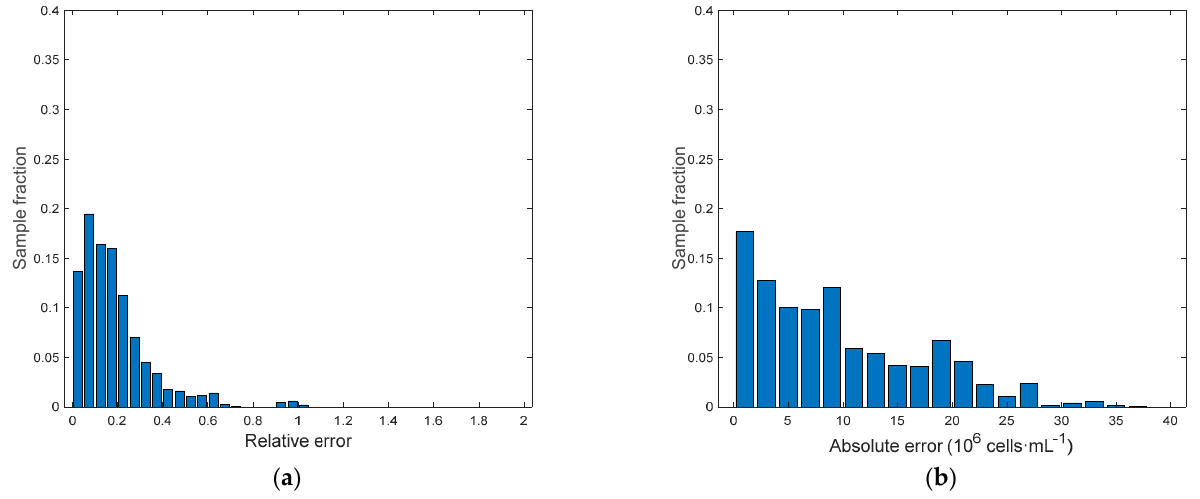
Figure 9. Model C[ 𝐗 𝐂𝐈 |𝐗 𝐅𝐈 ‖ ln(C x )]. ( a ) Relative error distributions. ( b ) Absolute error distributions. In view of the results above, where only wells at D0 were used for calibration and validation, an additional model was built where the number of variables was increased by using the features extracted from diluted wells (Figure 10). The best prediction perfor- mances were obtained by using three dilutions, namely D1, D2 and D3, for example, re- moving noisy dilutions. Matrix 𝐗 was therefore increased to (6 + 7)·4 = 52 predictors. The target concentration was again the logarithm of wells at D0 and the performance of this model D[ 𝐗 𝐂𝐈 |𝐗 𝐅𝐈 ‖ ln(C x )] are summarized in Table 3. We can see in Figure 11 that errors are significantly smaller with respect to the ones obtained with C[ 𝐗 𝐂𝐈 |𝐗 𝐅𝐈 ‖ ln(C x )]. In addi- tion, by looking at the parity plot in Figure 12, predictions at the highest concentrations were improved with respect to Figure 8d. In general, this model was very effective at characterizing biomass concentration in a wide range, although the need to provide sev- eral dilutions of the culture makes its application on µPBR potentially problematic (alt- hough it can represent a viable solution at a larger scale).